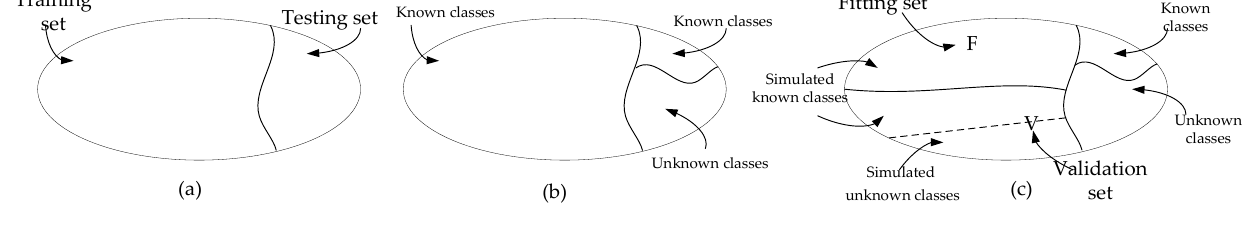
Figure 8. The division of jamming dataset.